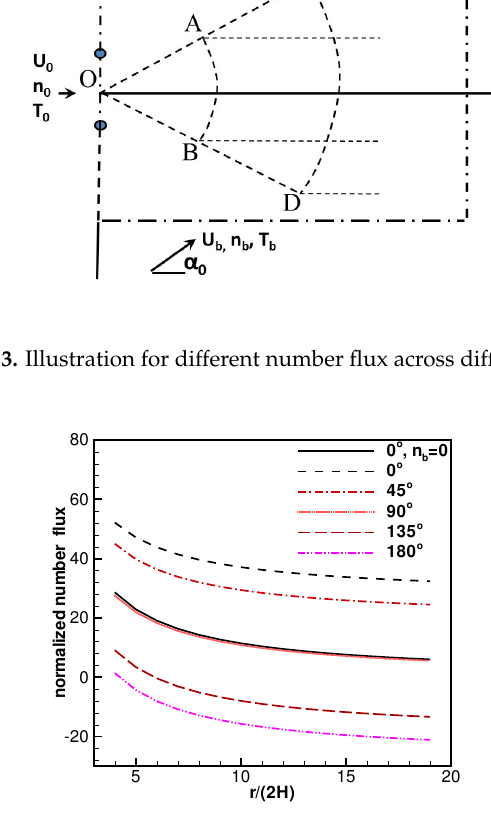
Figure 14. Background flow effects on the total number flux rate across different radius (normalized √ by n 0 2 RT 0 ), within angle span − 75 ◦ < θ < 75 ◦ , n b / n 0 = 0.5, S 0 = 0.2, S b = 0.1, T 0 = 200 Kelvin, and T b = 300